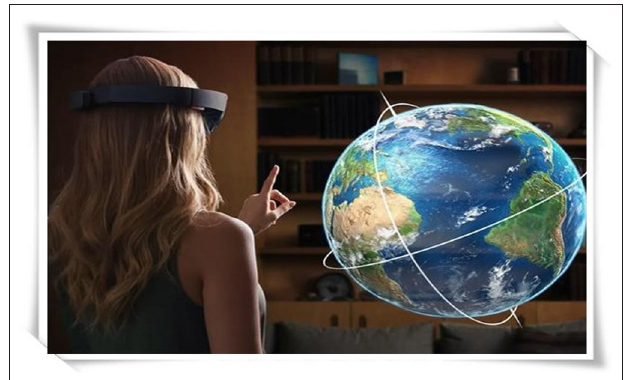
FIGURE 2 | Application of VR technology (http://alturl.com/pxm5z).